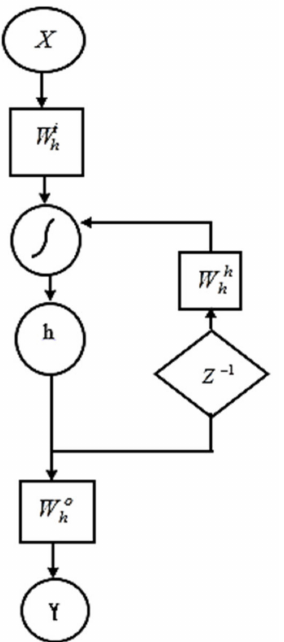
Figure 4. Recurrent neural network